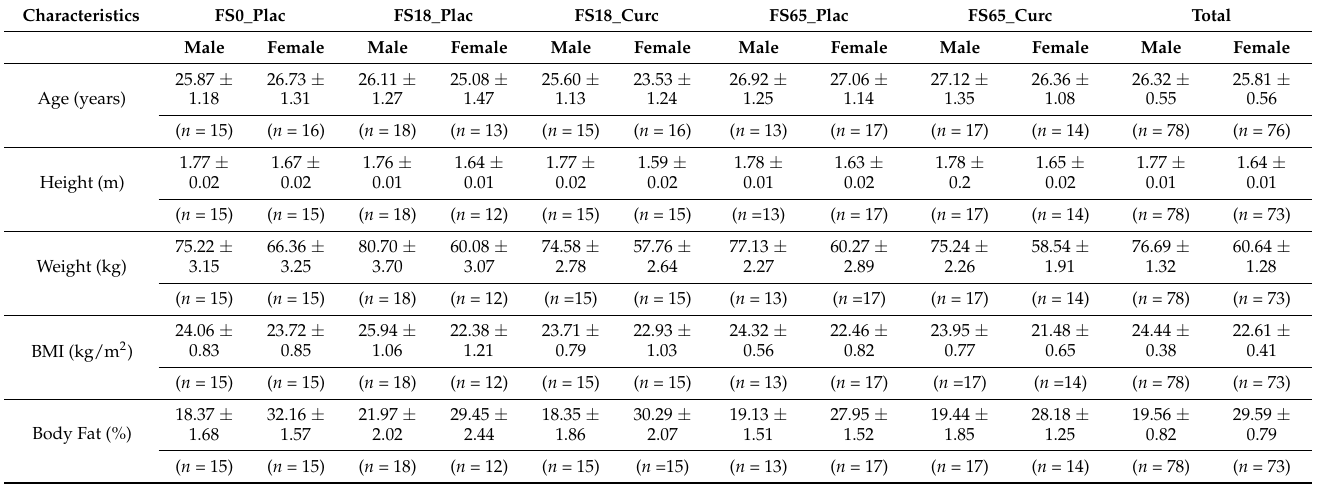
Table 1. Anthropometric characteristics of participants split by